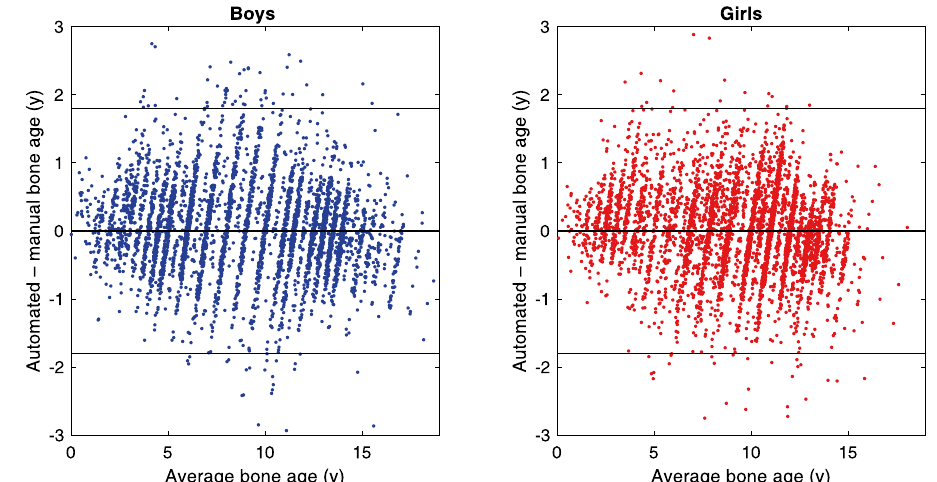
Figure 3. The agreement between automated and manual rating in the three Tübingen studies of children with Short Stature, Congenital Adrenal Hyperplasia or Precocious Puberty. The manual ratings are the original manual ratings without any corrections. The lines at ± 1.8 years define the disputed cases to be rerated 3 times. On the horizontal axis is the average of manual and automated bone age rating.